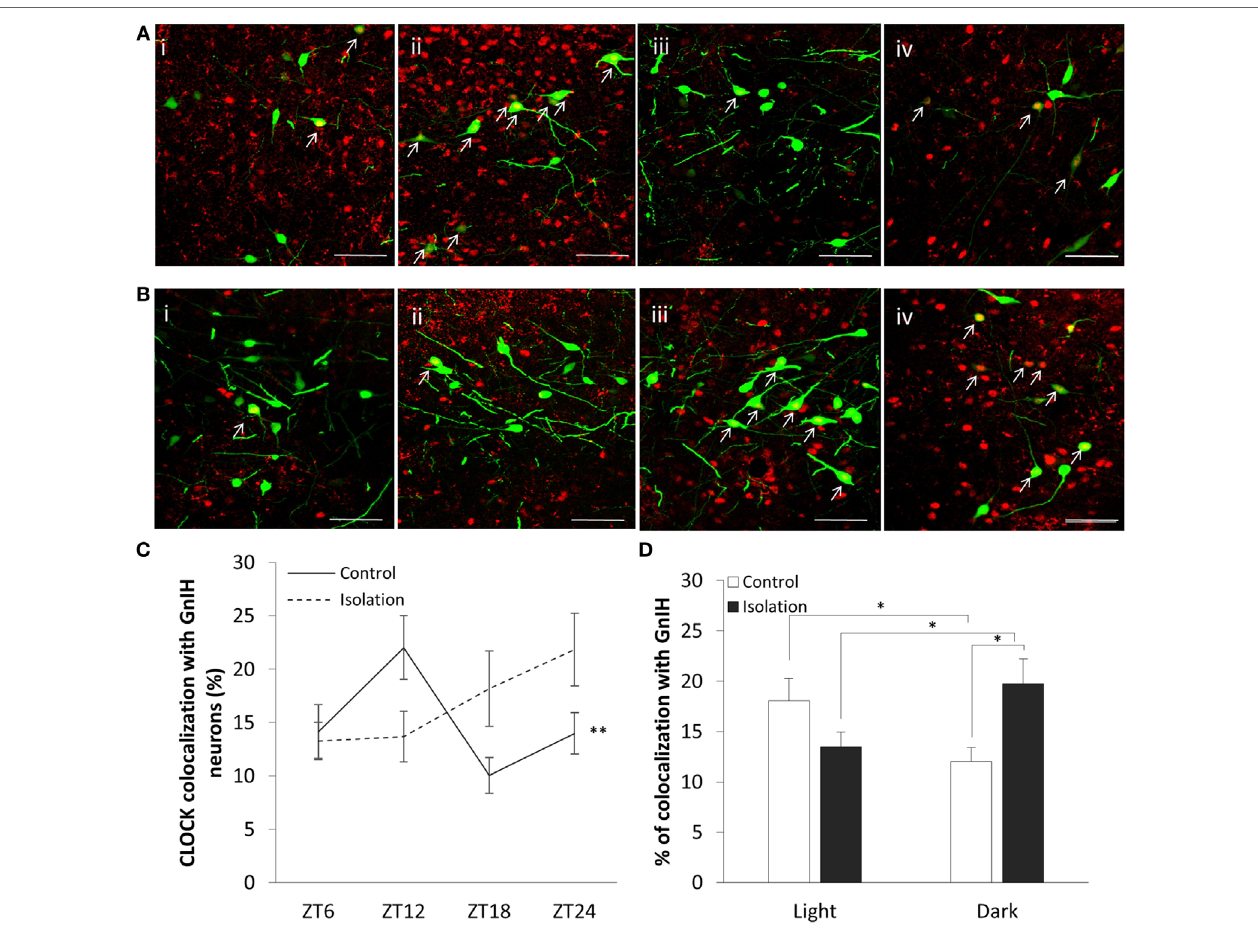
FigUre 3 | Colocalization of CLOCK protein within gonadotropin-inhibitory hormone (GnIH) neurons in the dorsomedial hypothalamus (DMH) region across different time points. (a) EGFP-GnIH neurons (green) and CLOCK-immunostaining (red) in the DMH of group-housed rats sampled at ZT6 (i), ZT12 (ii), ZT18 (iii), and ZT24 (iv). (B) EGFP-GnIH neurons (green) and CLOCK-immunostaining (red) in the DMH of isolation-housed rats sampled at ZT6, ZT12, ZT18, and ZT24. White arrows indicate colocalization between GnIH neurons and CLOCK protein. Scale bar = 50 µm. (c) Comparison of CLOCK colocalization percentage in the GnIH neurons of control and isolated rats over time (ZT 24 = lights on, ZT 12 = lights off, control: ZT6 n = 6, ZT12 n = 6, ZT18 n = 6, ZT24 n = 6 and isolation: ZT6 n = 6, ZT12 n = 7, ZT18 n = 8, ZT24 n = 6). (D) Comparison of CLOCK colocalization percentage in the GnIH neurons of control and isolated rats, grouped by light (ZT6 and ZT12) and dark (ZT18 and ZT24) phases (control: light n = 12, dark n = 12 and isolation: light n = 13, dark n = 14). Data are presented as means ± SEM for each set. Significance was set at p <